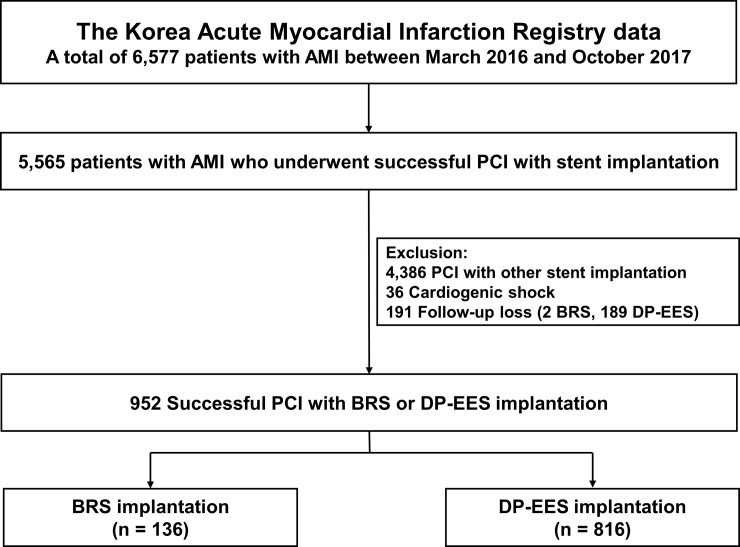
Study flowchart.